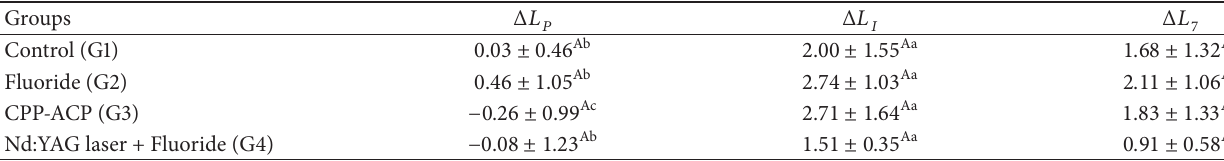
Table 3: Means and standard deviations for the Δ𝐿 values.